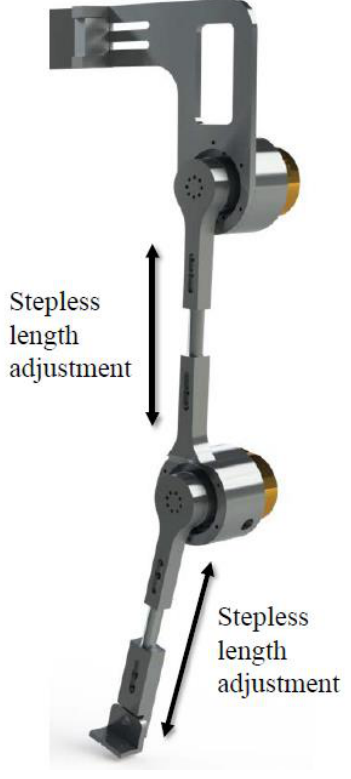
Figure 6. Adjustable leg rods of LLRE-II.